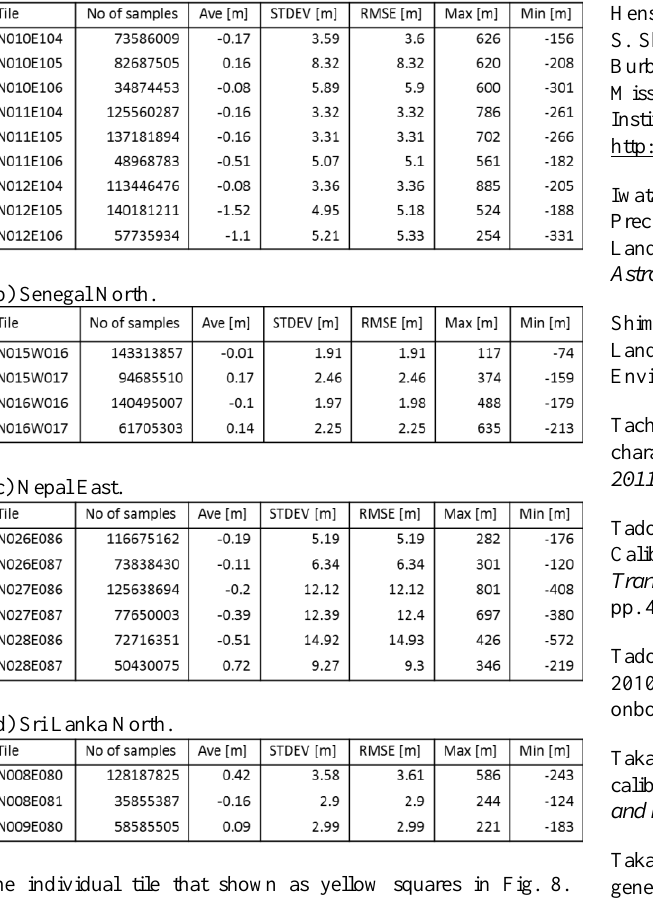
Table 3. Height difference stats for each tile in test processing. (a) Cambodian